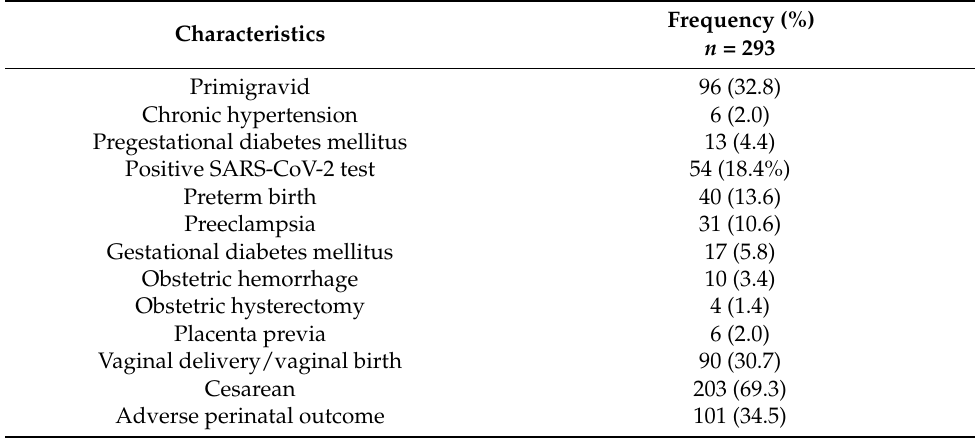
Table 2. Characteristics of pregnancy and delivery.